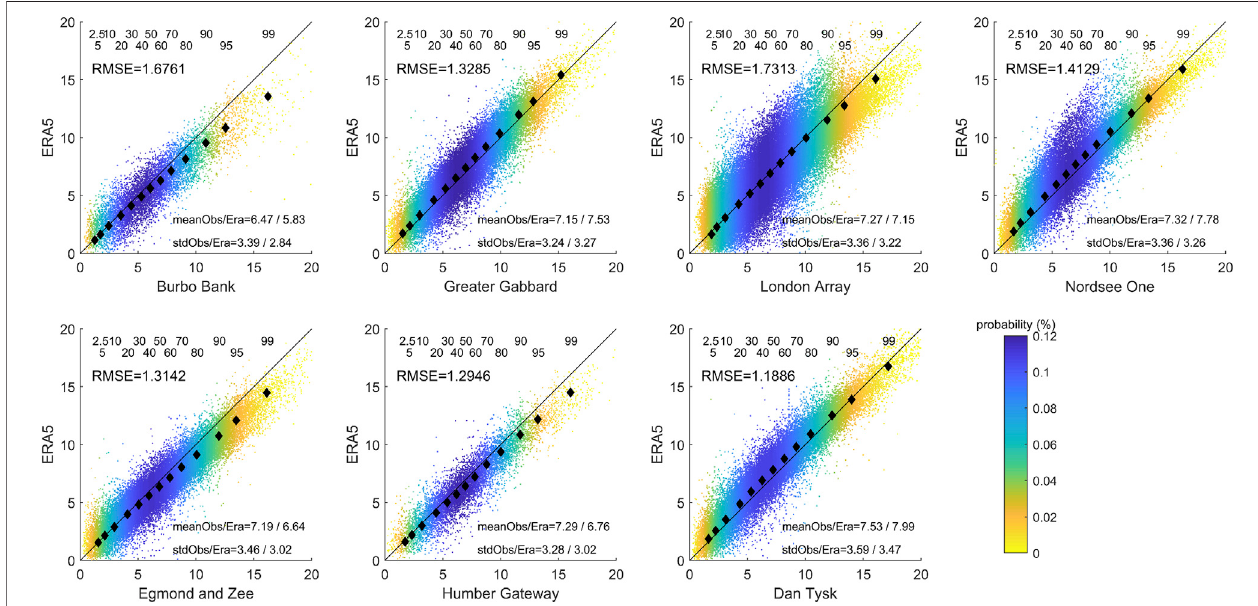
FIGURE 2 | Comparison of ERA5 against the in-situ measured data at the seven analyzed offshore parks. Probability scatter diagrams are colored by density of data.Blackdiamondsarethequantiles,from2.5to99asindicatedonthetopofeachpanel.ThedifferenceinthemeanandstandarddeviationaswellastheRMSE(m/s) are also